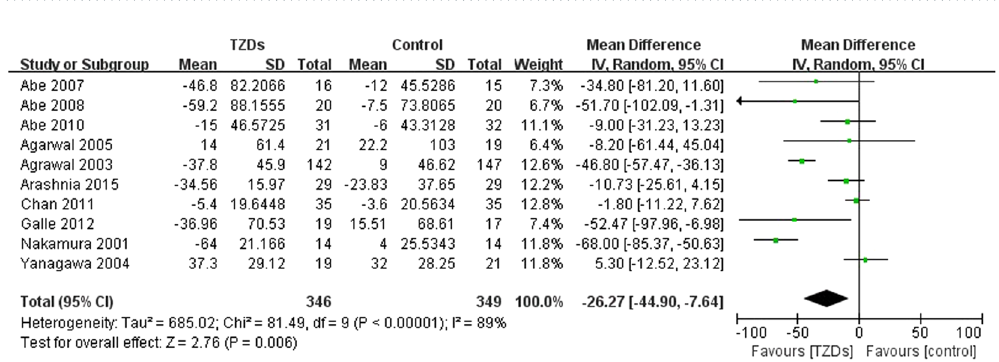
Figure 2. Change in HbA1c among patients with diabetes mellitus and renal impairment receiving TZDs versus control from RCTs.